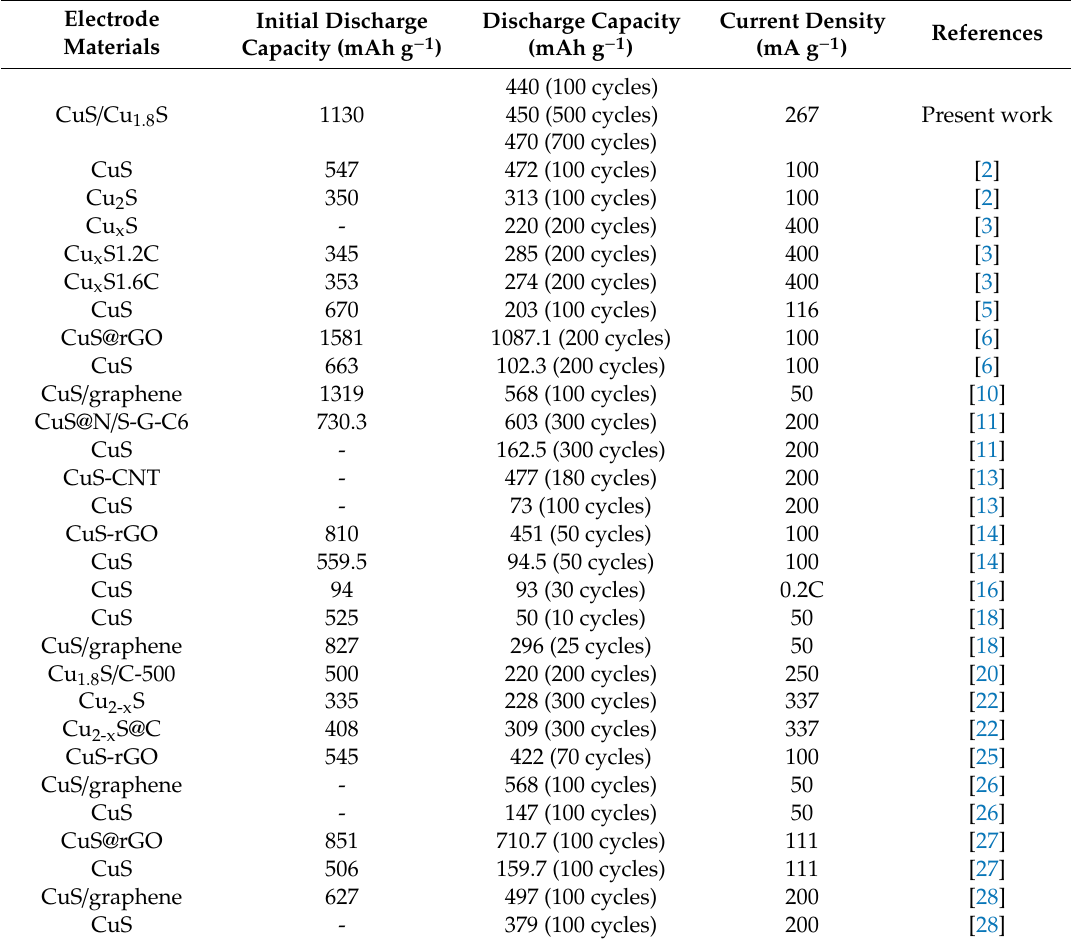
Table 1. Comparison of electrochemical performances of CuS / Cu 1.8 S nanocomposites with previously reported CuS-based